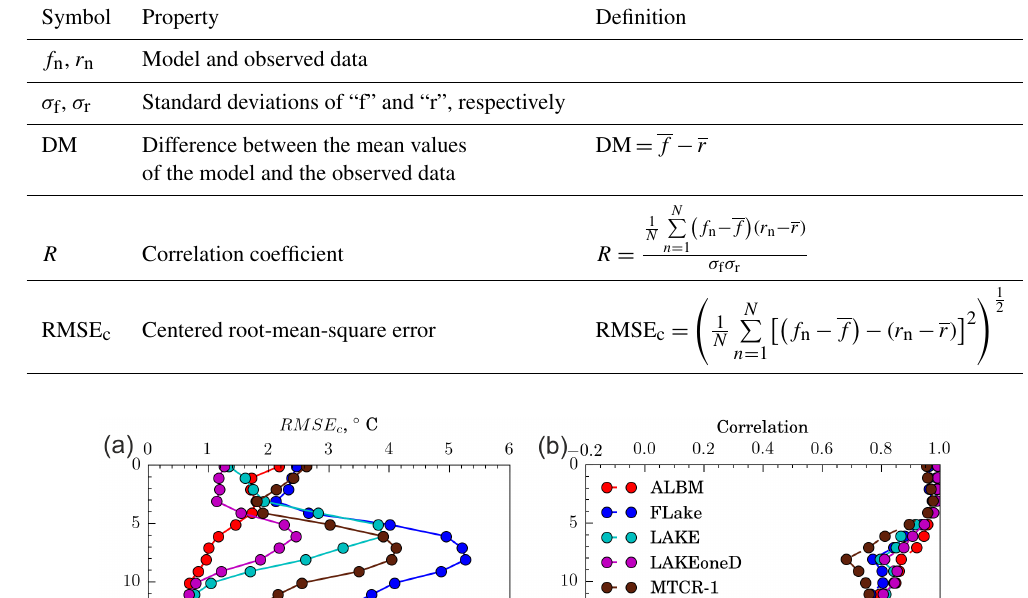
Table 4. Statistical measures of model performance.